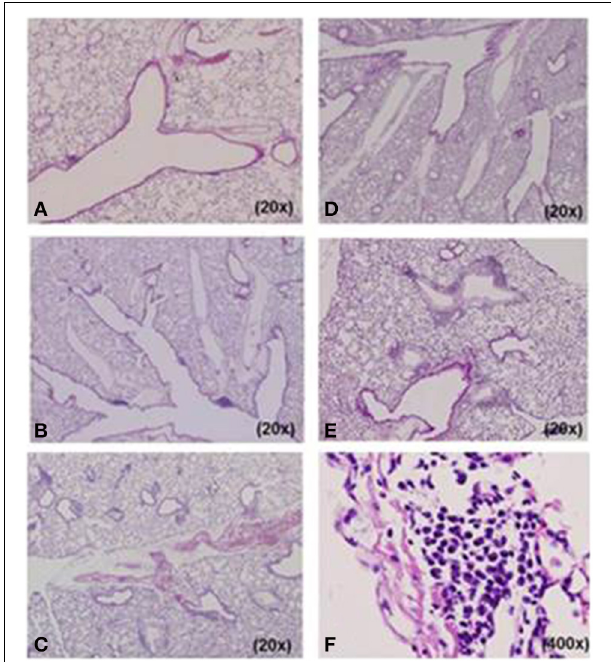
FIGURE 2 | Histopathological examination of lung specimens. At 96h post-intratracheal (IT) challenge, no inflammatory cells were seen in model (A) A or (B) B specimens. Mild to moderate lymphocyte infiltration was observed in the peribronchovascular area (PBVA) of (D) model D tissue. Models (C) C and (E) E had more severe lymphocyte infiltration in the PBVA. Plasmacyte infiltration within the PBVA was only recognized in models D and E, and the number of infiltrating plasmacytes was significantly higher in model E than model D. (F) High power magnification of E. Hemotoxylin and eosin stain. A–F , 200x; E ,